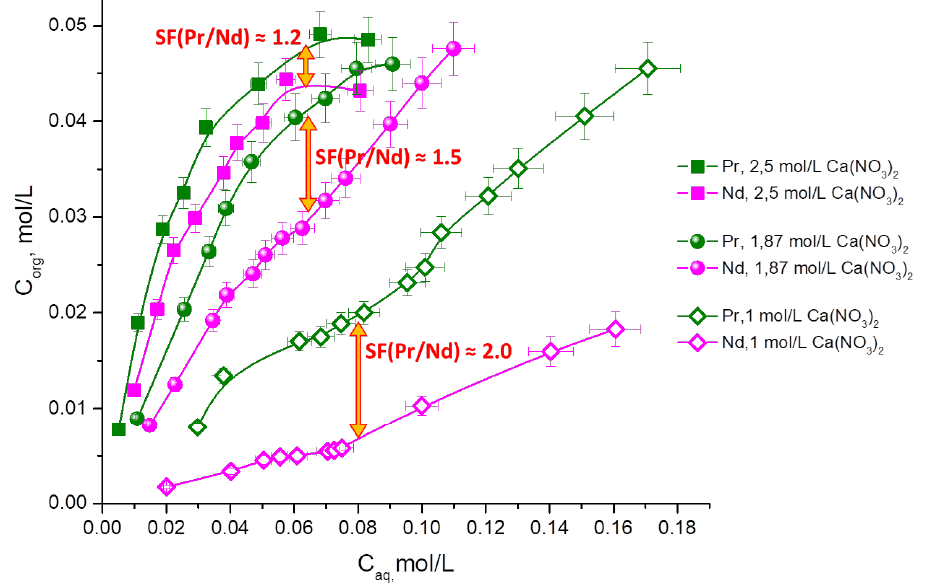
Figure 3. Extraction isotherms for the system “0.5 mol · L − 1 Aliquat 336 in dodecane / 10% vol. 1-octanol—Pr(NO 3 ) 3 and Nd(NO 3 ) 3 + Ca(NO 3 ) 2 + 0.3 mol · L − 1 HNO 3 ”.